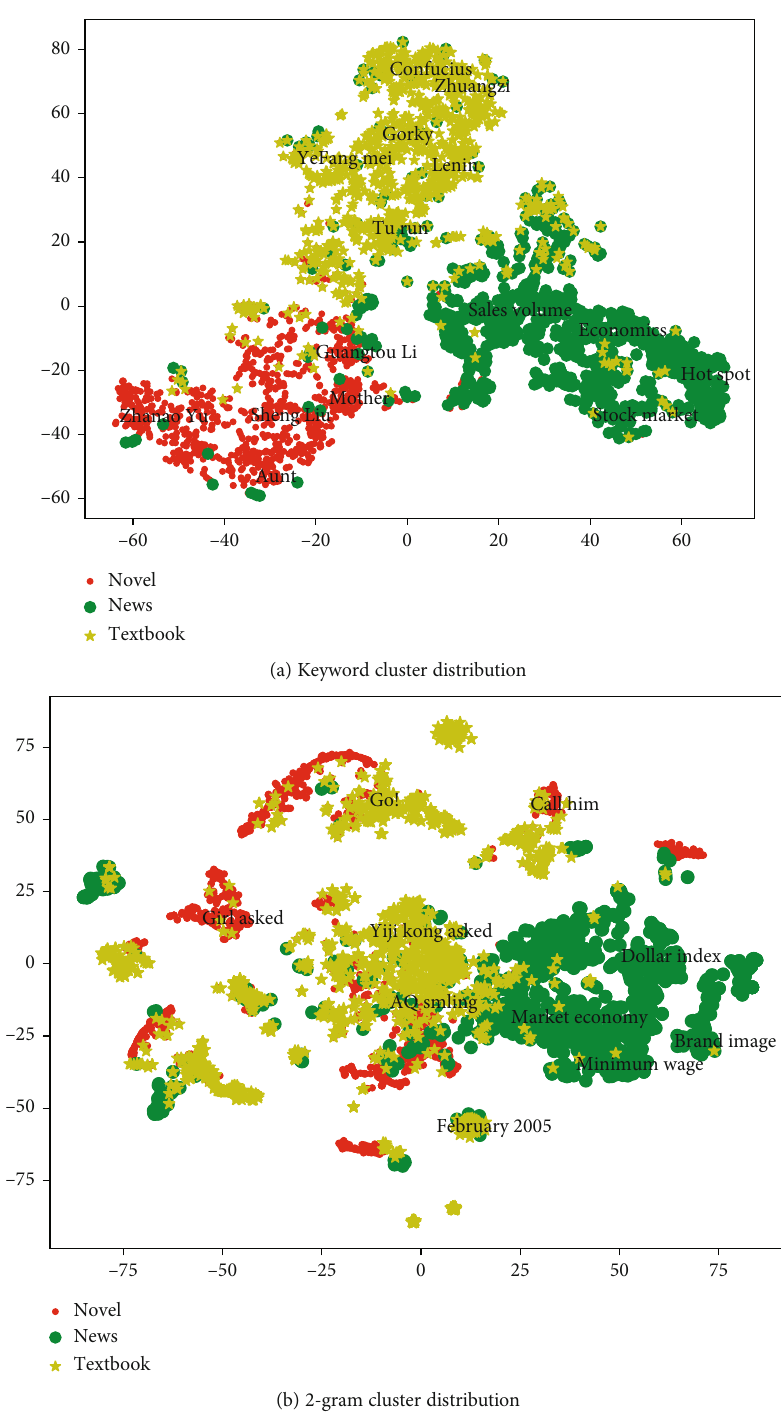
Figure 7: Keyword and 2-gram clustering based on t -SNE